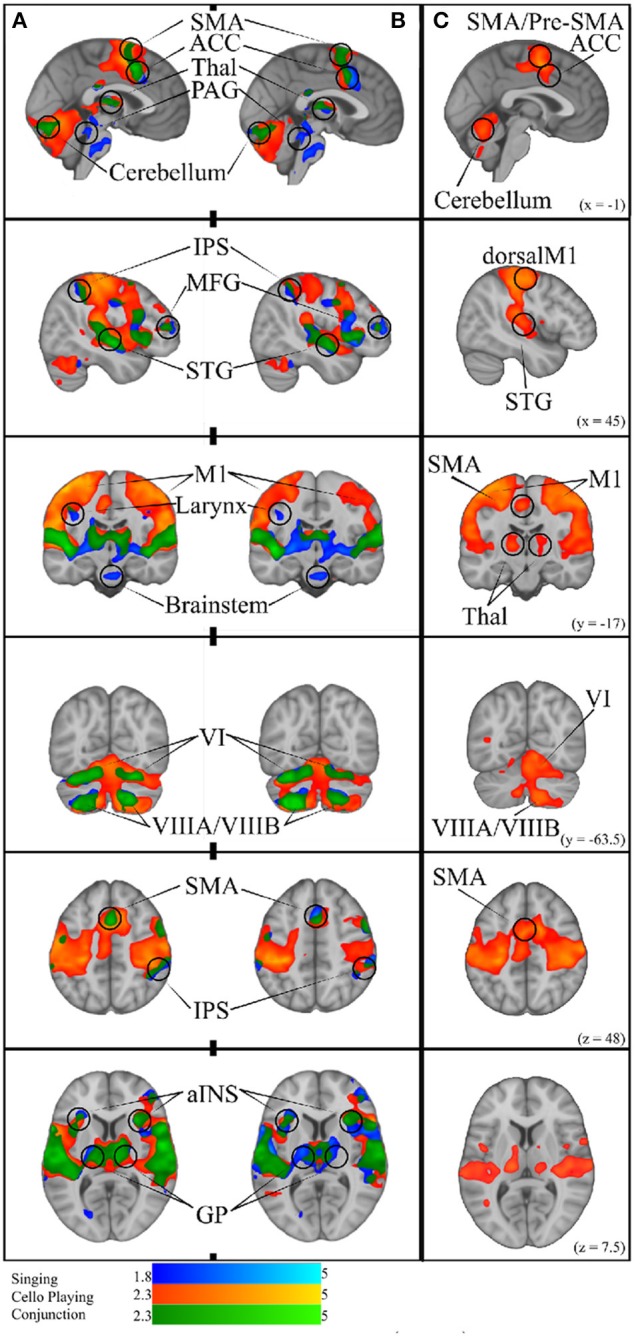
(A) Simple Singing (blue), cello playing (orange), and conjunction (green). (B) Simple singing (blue), cello playing (orange) and conjunction (green) regressed by task accuracy with better performance correlated with more activation. The conjunction of singing and cello playing shows overlapping activation in SMA, ACC, Thalamus, PAG, IPS, MFG, STG, MI (larynx area for singing), aINS, GP, and VI, and VIIIA/VIIIB of the cerebellum. All of these regions were positively correlated with better intonation. (C) Cello playing > Singing throughout dorsal motor and premotor regions, SMA/Pre-SMA., posterior STG, Thalamus, and Cerebellum.